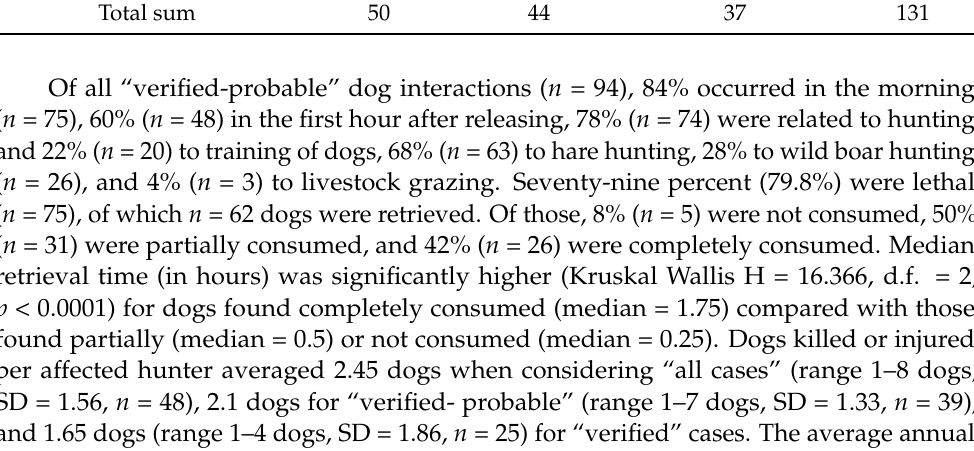
Table 1. Classification of the overall number of reported dog interactions for the period 2005–2020. Number of Dogs Interaction “Verified” “Probable” “Alleged-Claimed” Total Only approach and attack 10 2 1 13 Injury 6 1 1 8 Death 34 41 35 110 Total sum 50 44 37